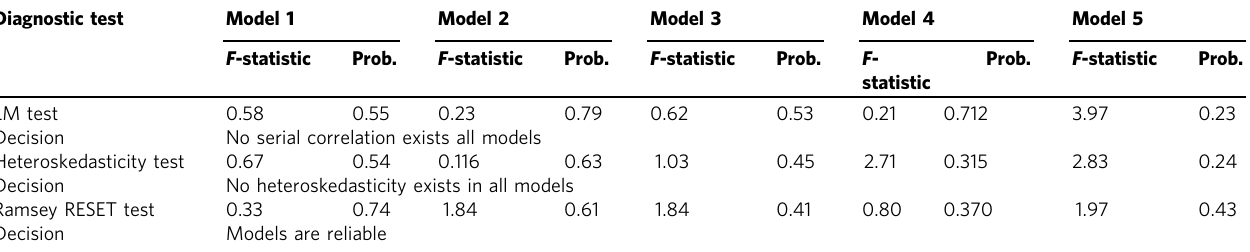
Table 5 Diagnostic